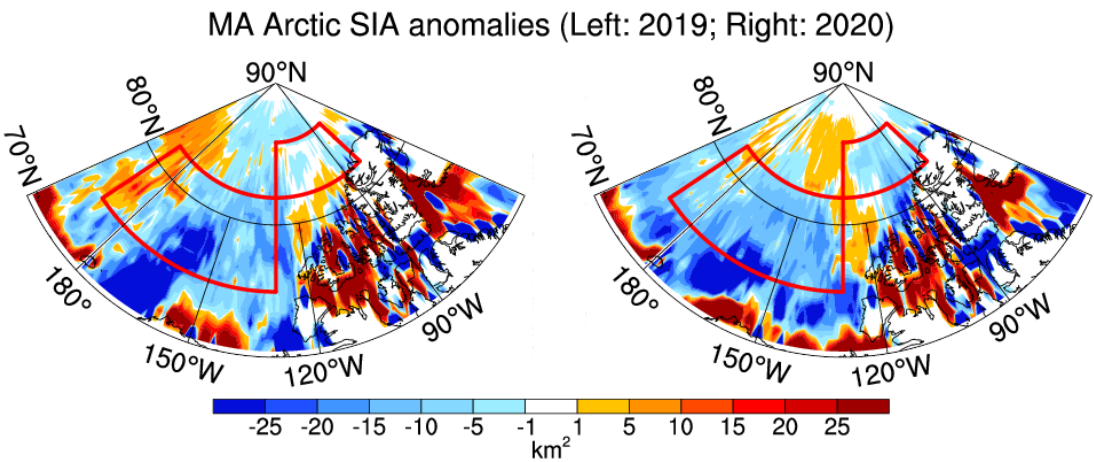
Figure 13. Anomalies of the MA–mean Arctic SIA in 2019 ( left panel ) and 2020 ( right panel ). The base period is 1980–2020.